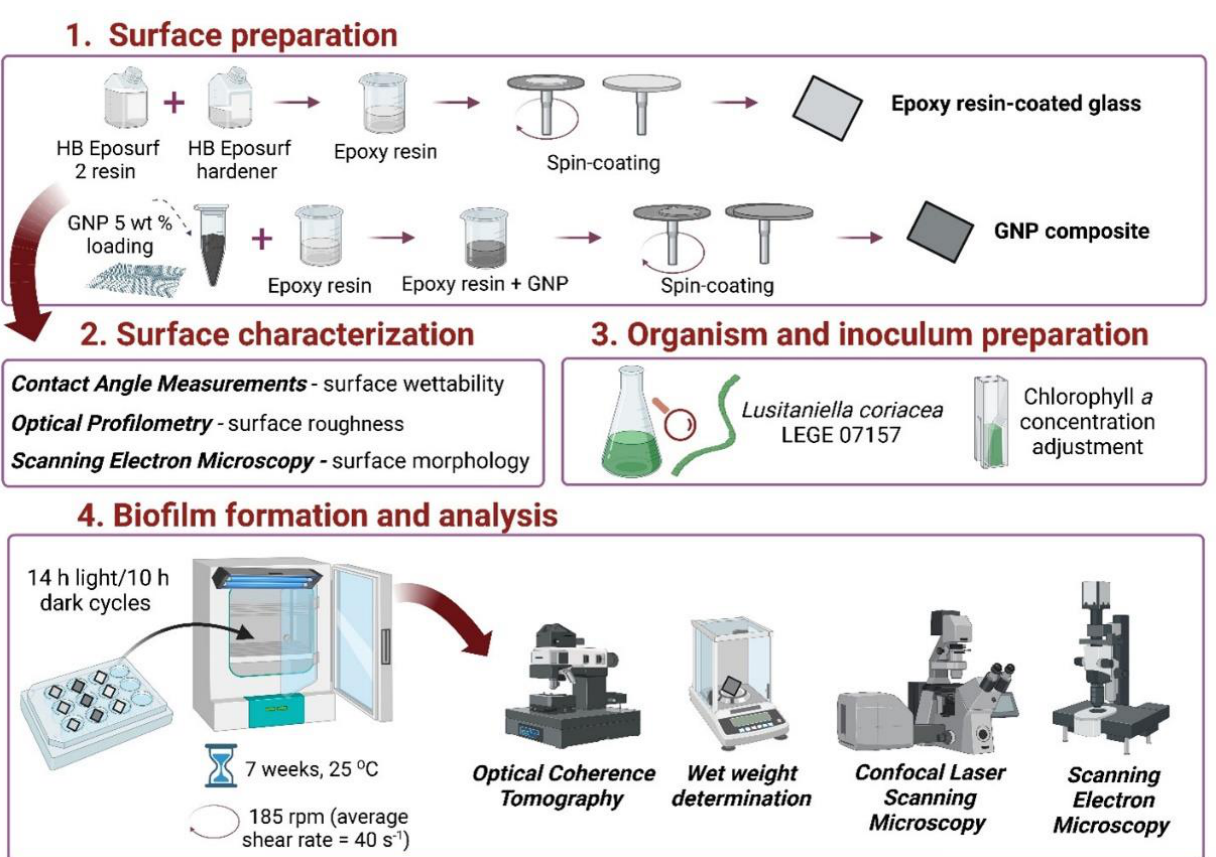
Figure 1. Scheme of the experimental steps of the present work.